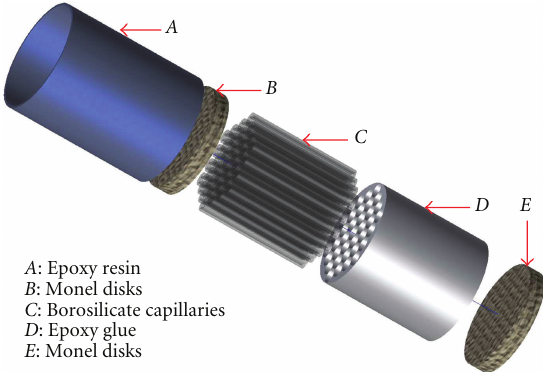
Figure 4: Exploded view of the capillary core.